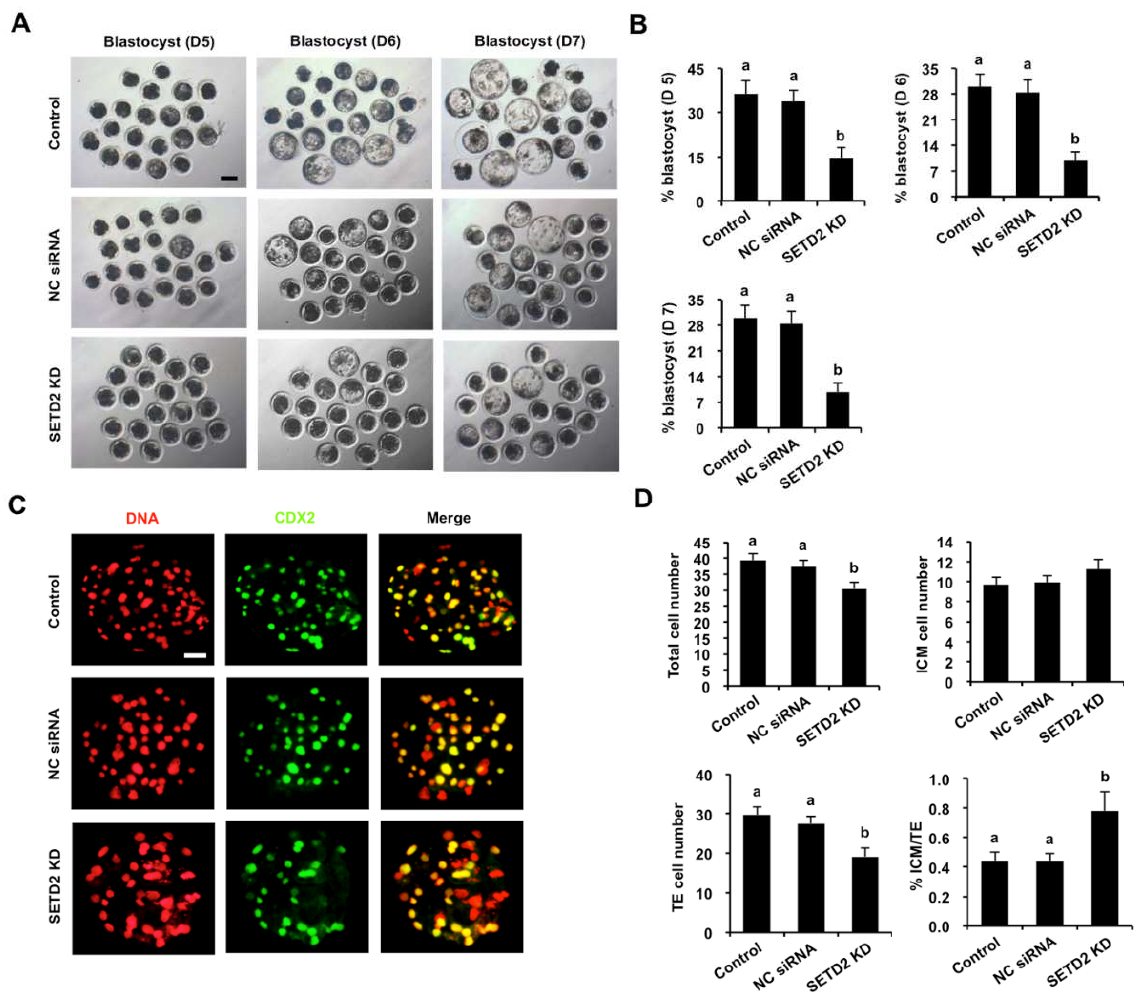
Figure 4. Effects of SETD2 KD on blastocyst rate and cell allocation. ( A ) Representative brightfield images of blastocysts in each group. Scale bar: 100 µ m. ( B ) Developmental rates of blastocysts at day 5, 6 and 7. The independent experiment was carried out three times, and at least 30 embryos in each group were included. ( C ) Representative fluorescence images. Blastocysts in each group were stained for CDX2 (green) and DNA (red). The independent experiment was carried out for three times, and at least 30 embryos in each group were included. Scale bar: 50 µ m. ( D ) Cell allocation in embryos from each group. The numbers of total cells, ICM, TE, and the ratio of ICM/TE cells were separately statistically analyzed. ICM: inner cell mass; TE: trophectoderm. All data are expressed as mean ± S.E.M, and different letters on the bars indicate significant differences ( p <